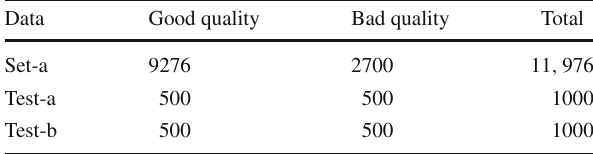
Table 1 Details of the datasets used in this paper